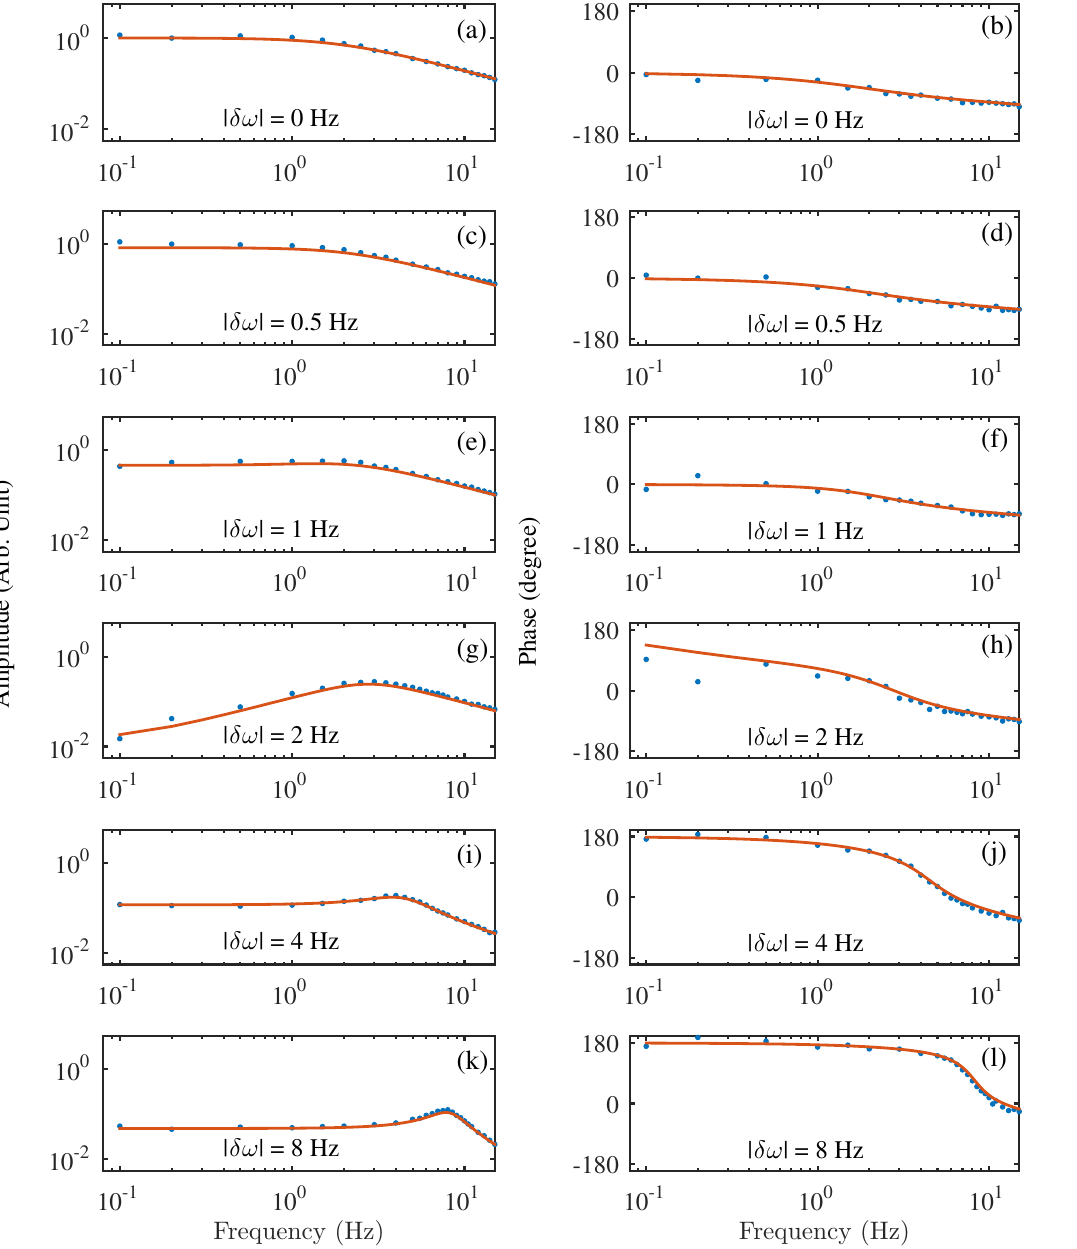
Figure 2. Frequency responses of the Bell–Bloom cesium OPM with different detunings between the Larmor frequencies and the modulation frequencies of the pump beam at a biasing magnetic field of 1.15 µ T. The figures in the left column represent the amplitude-frequency responses, while the figures in the right column represent the phase-frequency responses. The blue dots are the experimental results and the red lines are the simulated